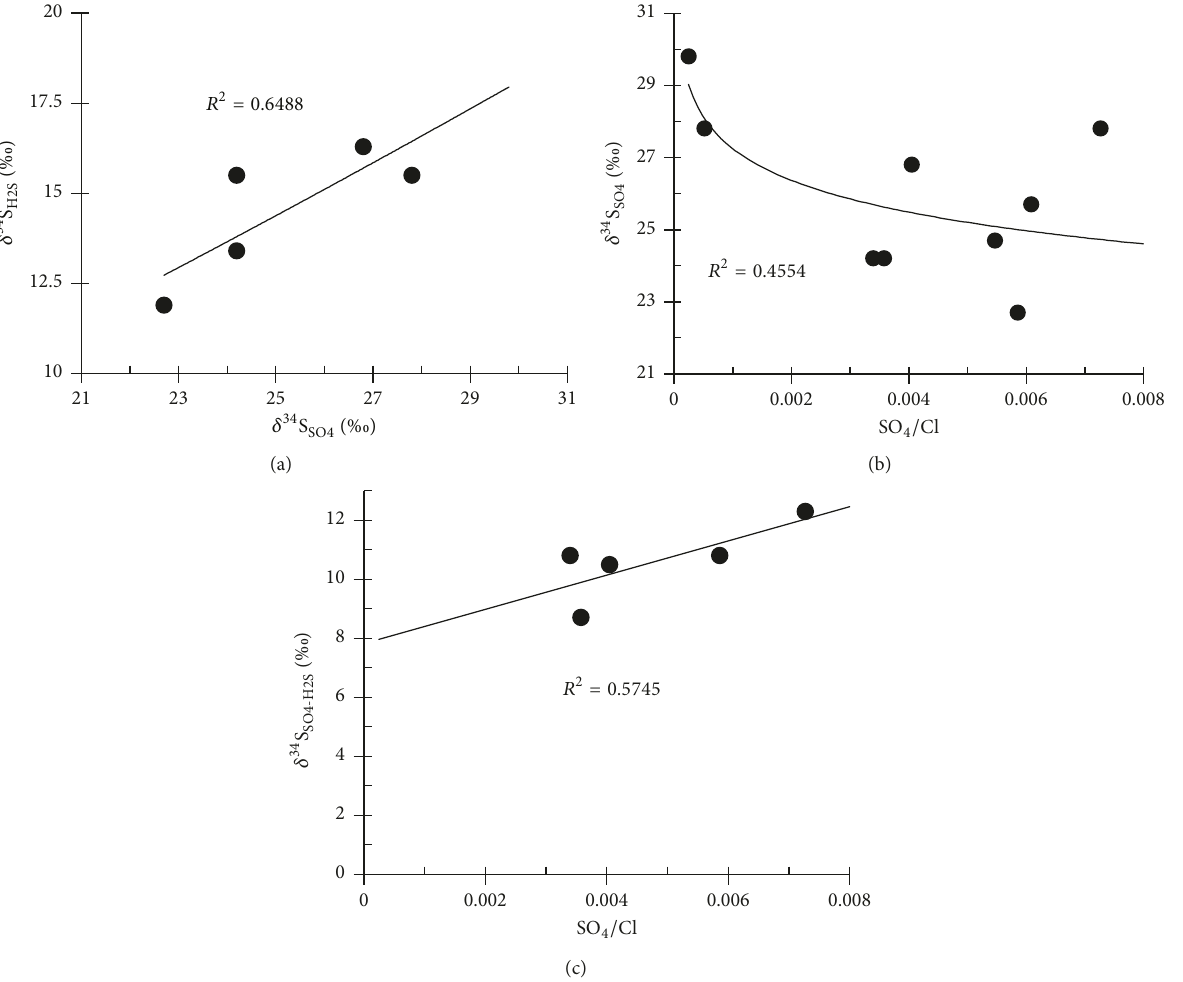
Figure 5: Relationship between (a) 𝛿 34 S SO 4 and 𝛿 34 S H 2 S ; (b) SO 4 /Cl and 𝛿 34 S SO 4 ; (c) SO 4 /Cl and 𝛿 34 S SO 4